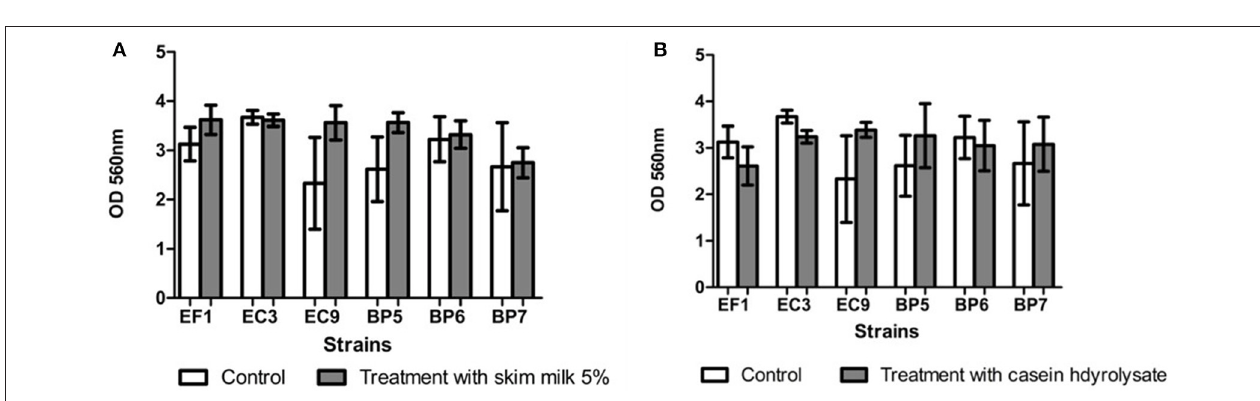
FIGURE 5 | Effect of addition of skim milk (A) and lactose casein hydrolysate (B) . Each value represents means ± SD.